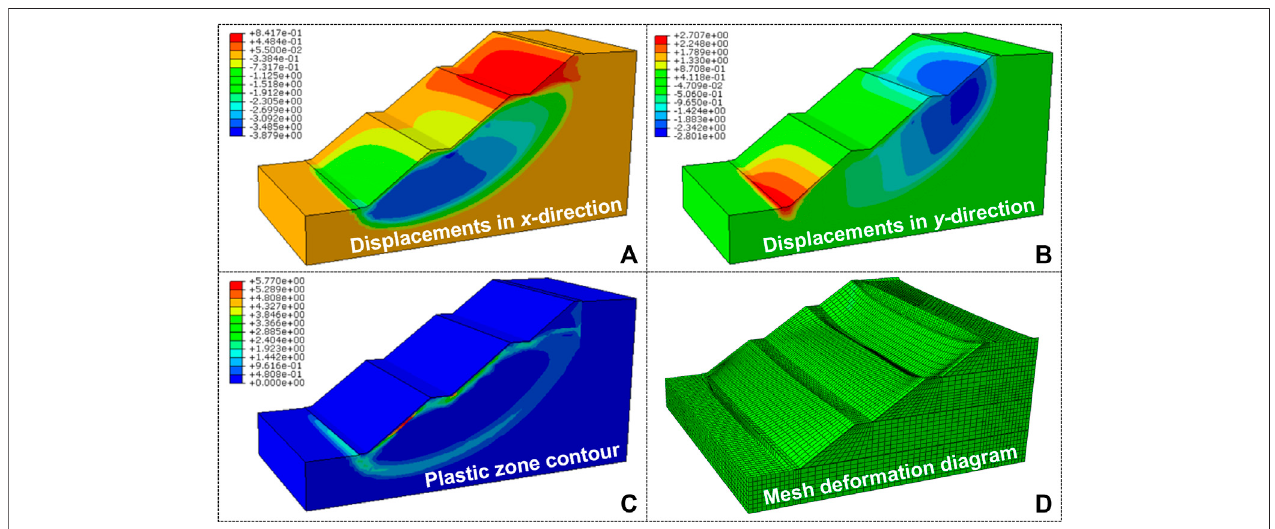
FIGURE 4 | (A) Displacement in x -direction; (B) displacement in y -direction; (C) plastic zone contour; and (D) mesh deformation diagram of the slope with the concrete-sprayed layer.